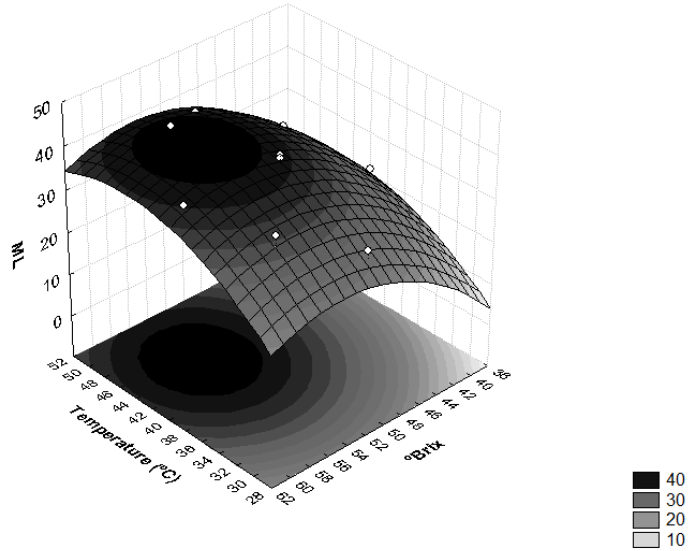
Figure 1. Surface response for moisture loss (ML) as a function of the concentration of sucrose solution (°Brix) and temperature (°C).